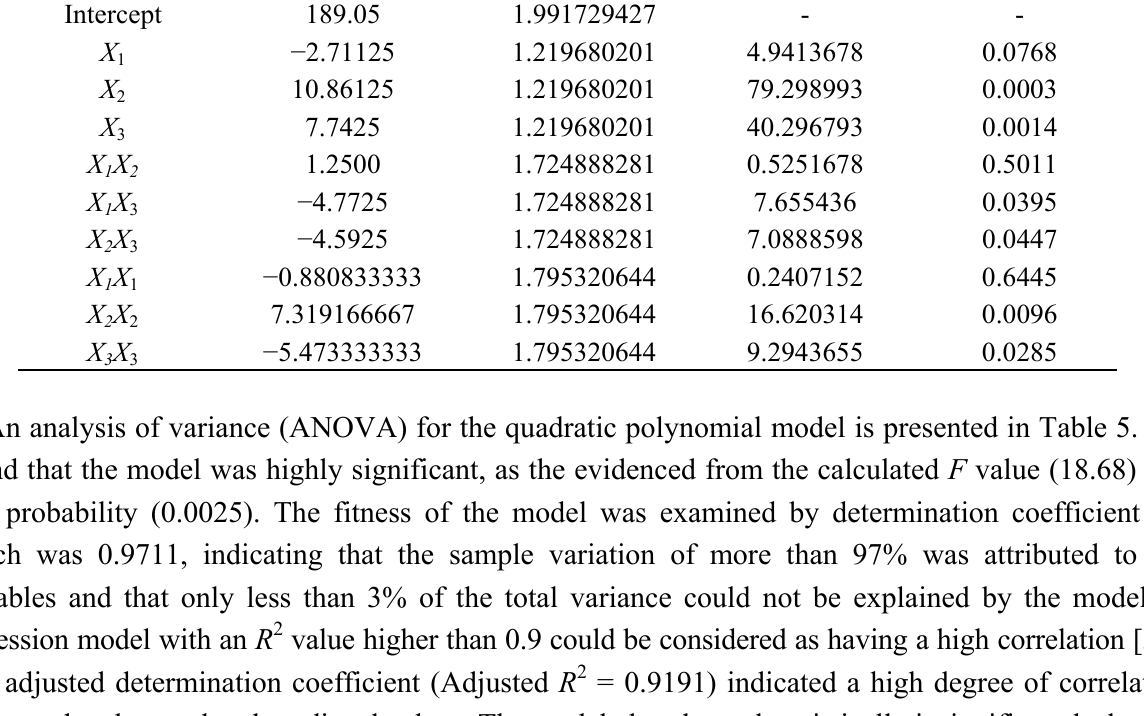
Table 4. Regression coefficients of the predicted quadratic polynomial model.